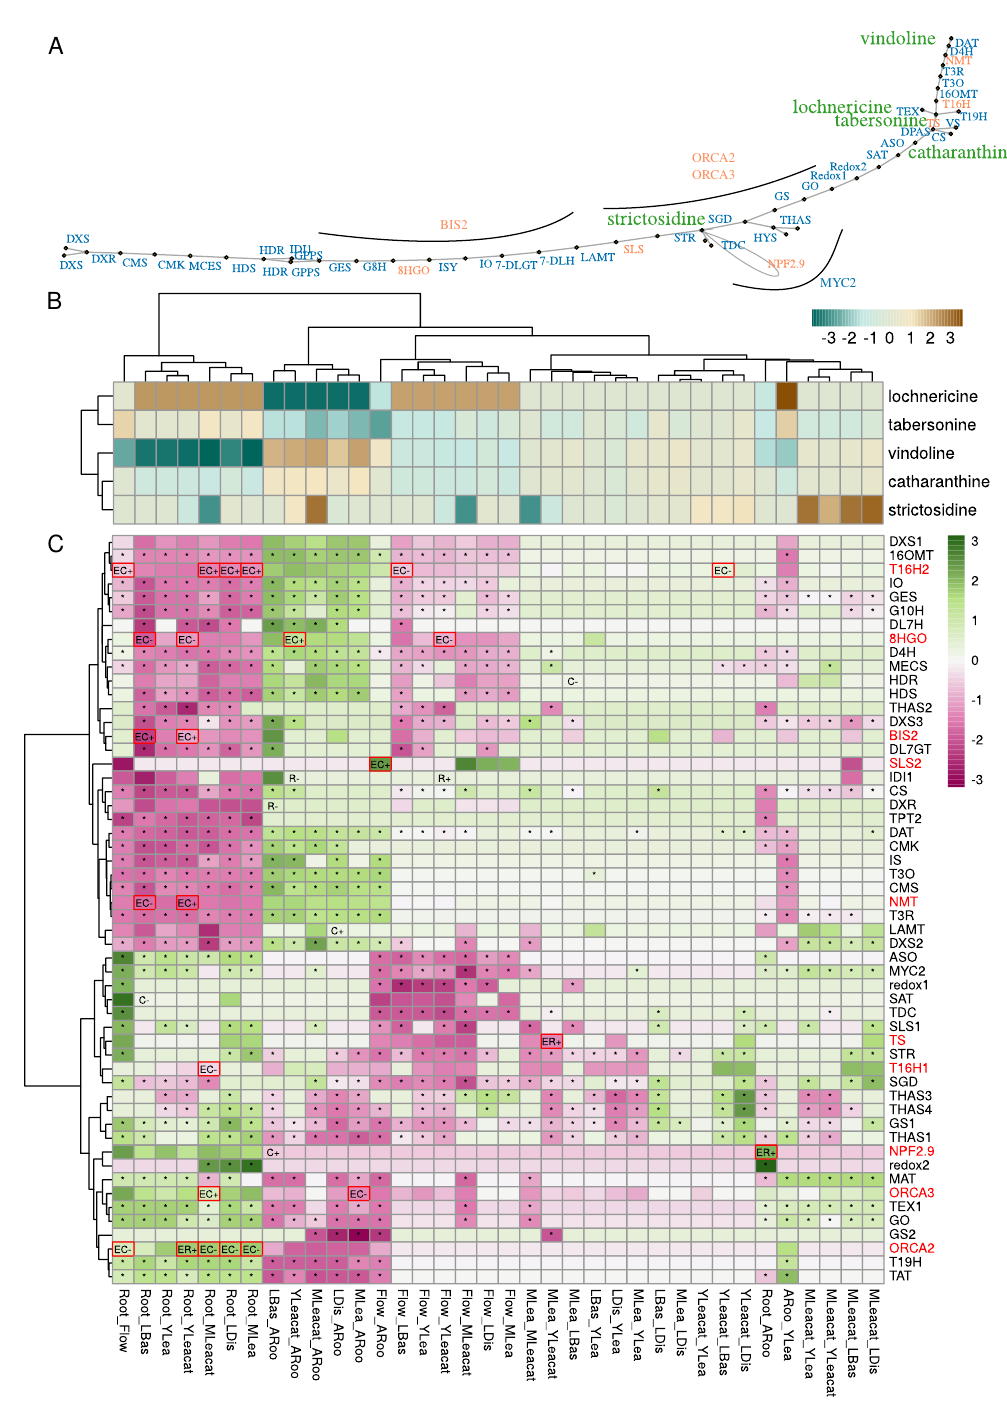
Figure 5. Methylation and expression variation in the MIA pathway. ( A ) MIA pathway. Differentially methylated genes are indicated in orange. Transcription factors BIS, ORCA2/3, and MYC2 are positioned close to their known targets. ( B ) Analysis of differential accumulation of metabolites. Each cell in the table represents the log10 transformed ratios of metabolite between samples. ( C ) differential expression analysis of genes involved in the MIA pathway. Cells show scaled log2 fold changes. *, differentially expressed (Sample1_Sample2). C − , hypomethylated DMC in sample1; C+, hypermethylated DMC in sample1. R-, hypomethylated DMR in sample1; R+ hypermethylated DMR in sample1. When a “E” is indicated before, it indicates that the gene is both differentially methylated and expressed. Differentially expressed and methylated genes (EC or ER) are surrounded by red boxes and their names indicated in